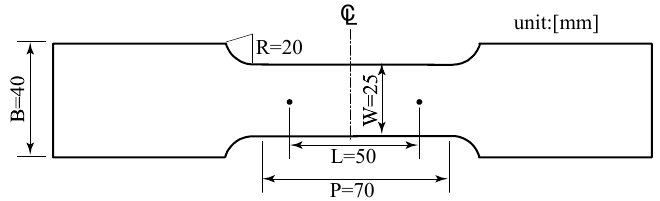
Figure 3. Japanese Industrial Standards No. 5 specimen dimensions.